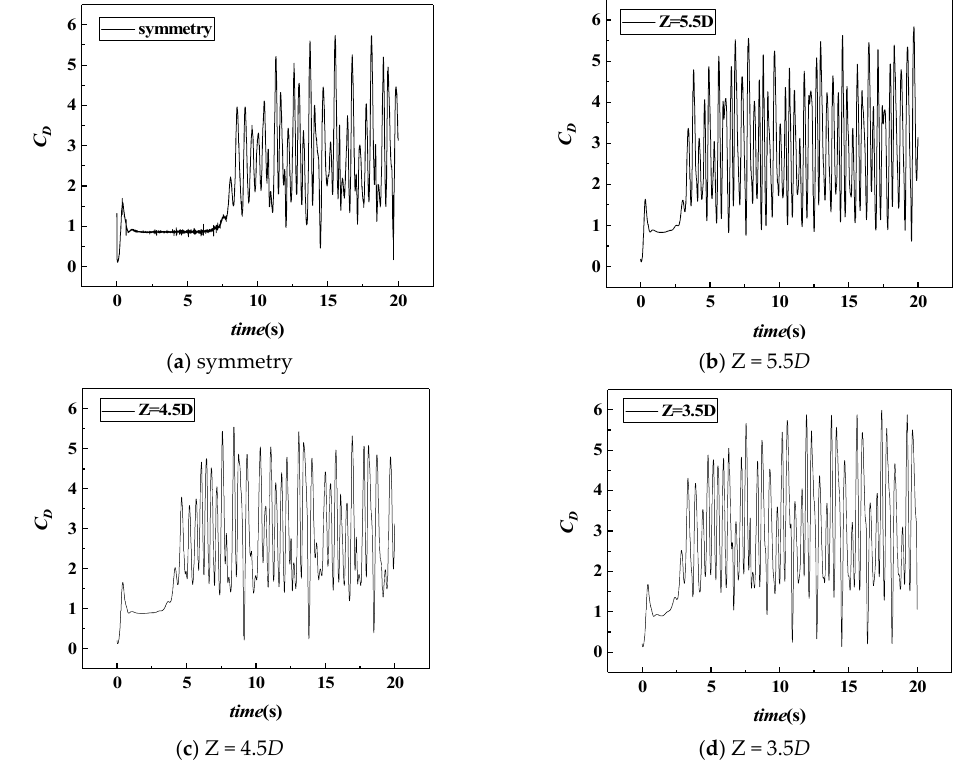
Figure 7. Time history of C D of the PTC cylinder flow-induced vibration for different Zs ( Re = 3.5 × 10 4 ).